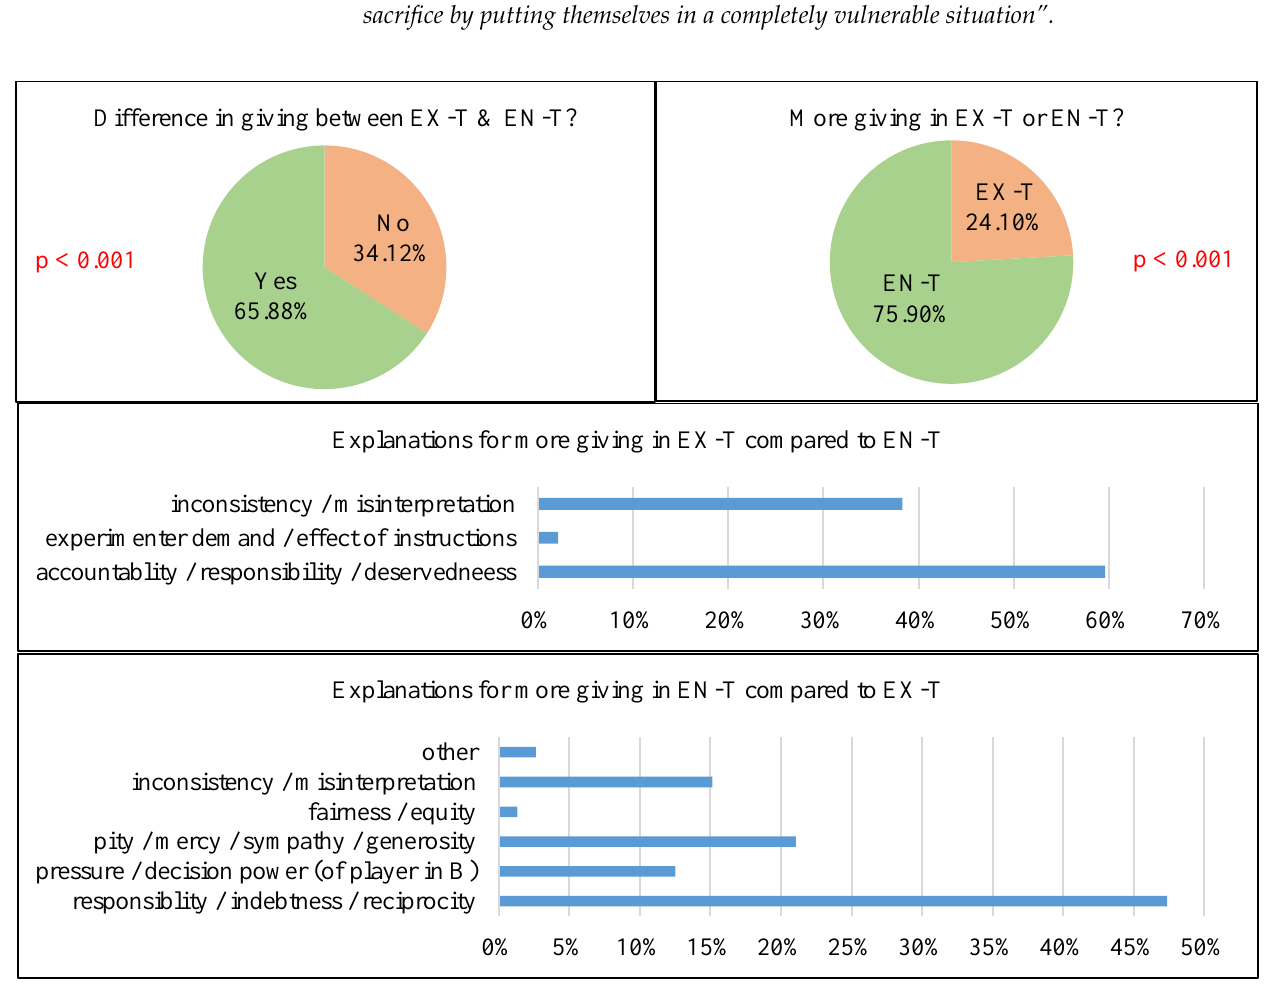
Figure 7. Survey results for Hypothesis 4 .